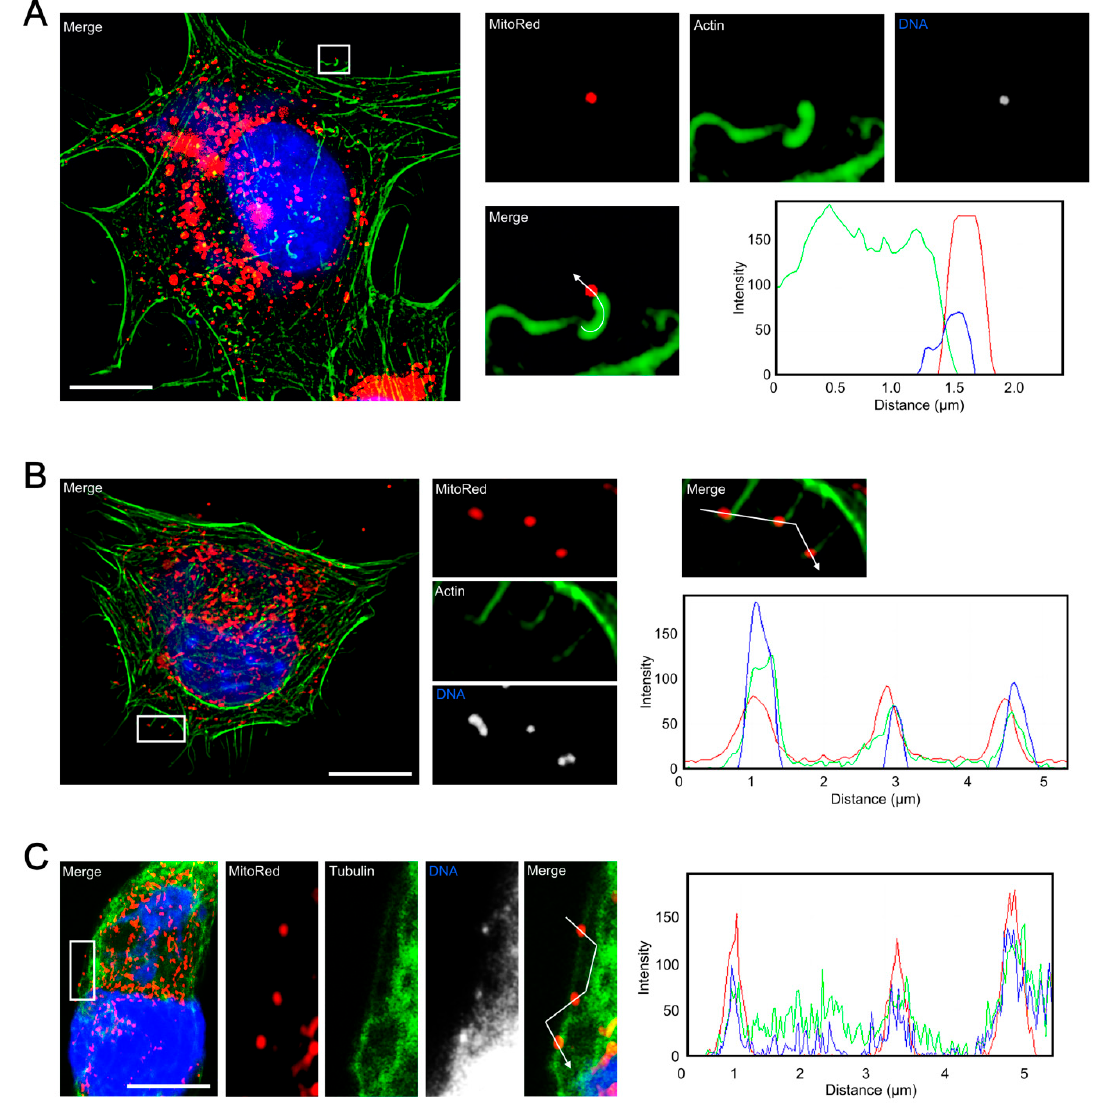
Figure 10. Punctate mitochondria co-localized with progeny virions interact with the cytoskeletal elements in ECTV-infected cells. ( A ) Mitochondrion co-localized with virion present on the top of the actin tail in MEF Mfn1 − / − /Mfn2 − / − cells at 18 hpi. ( B ) Mitochondria co-localized with virions present on filopodia in L929 cells at 18 hpi. ( C ) Mitochondria co-localized with virions present on microtubules in L929 cells at 18 hpi. The fluorescence intensity of mitochondria (red line), actin ( A , B ) or tubulin ( C ) (green line), and viral DNA (blue line) was measured along the white segmented arrows. Scale bar: 10 µm ( A – C ).